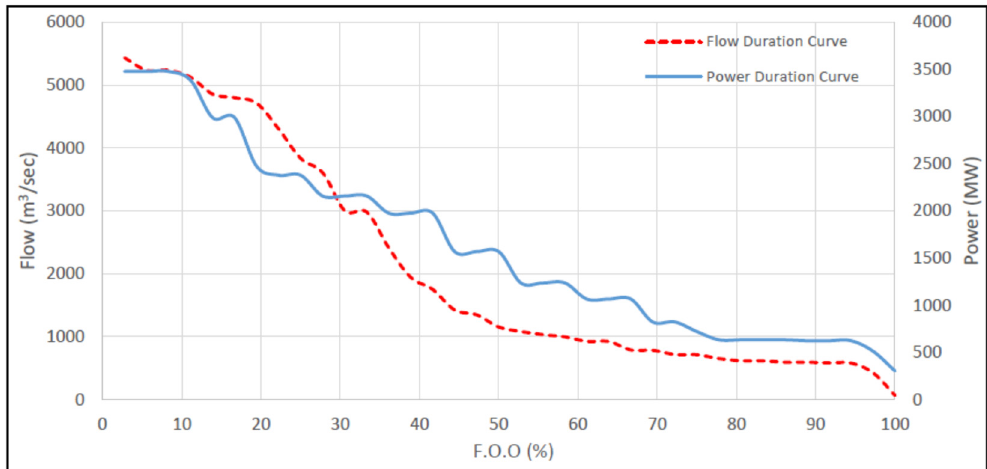
Figure 36. Flow and Power Duration curves for year 2008.